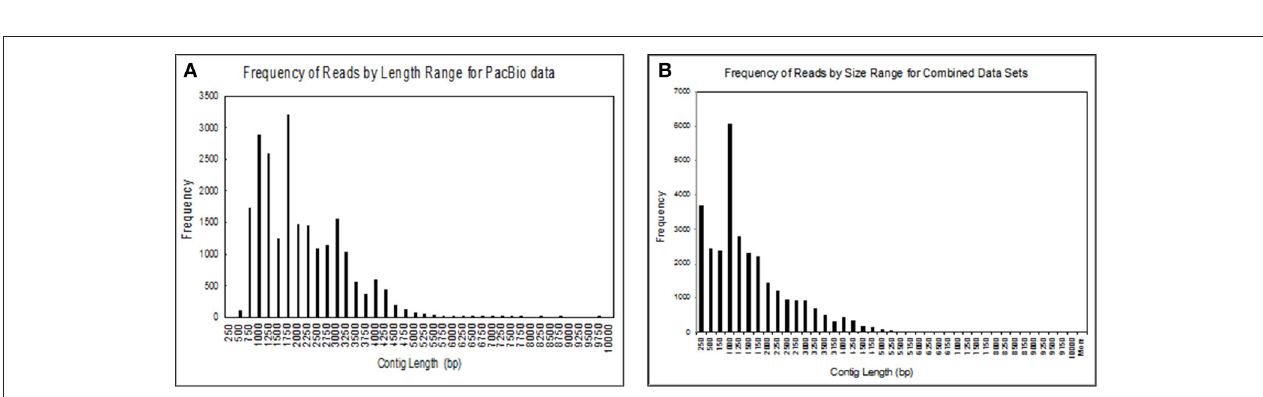
FIGURE 2 | Size distribution of contigs obtained from (A) sequences obtained from the Pac Bio instrument for brain, liver, gut, testes, heart, gill, head kidney, and trunk kidney from one male fathead minnow; (B) assembled sequences from the PacBio data with several Illumina RNAseq datasets including the one performed in this study. The assembled sequences include transcripts from male and female fathead minnows obtained in various other experiments.